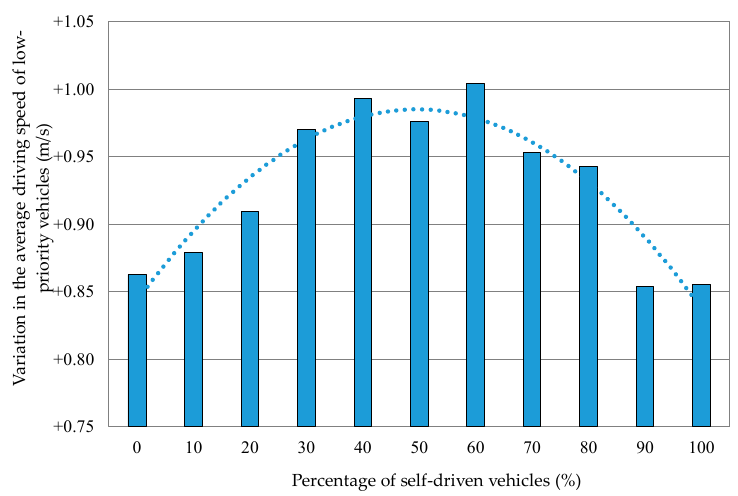
Figure 19. Variation in the average driving speed of low-priority vehicles when the percentage of self-driven vehicles was varied. The average driving speed was the average for all the vehicles that came in.